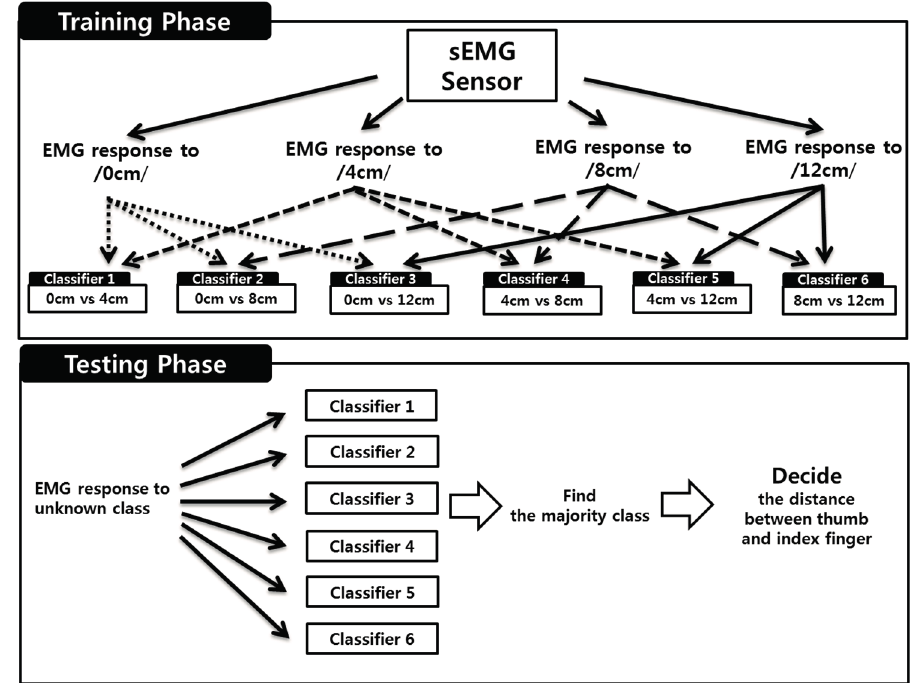
Figure 6. Diagram of classification algorithm for 4-class classification based